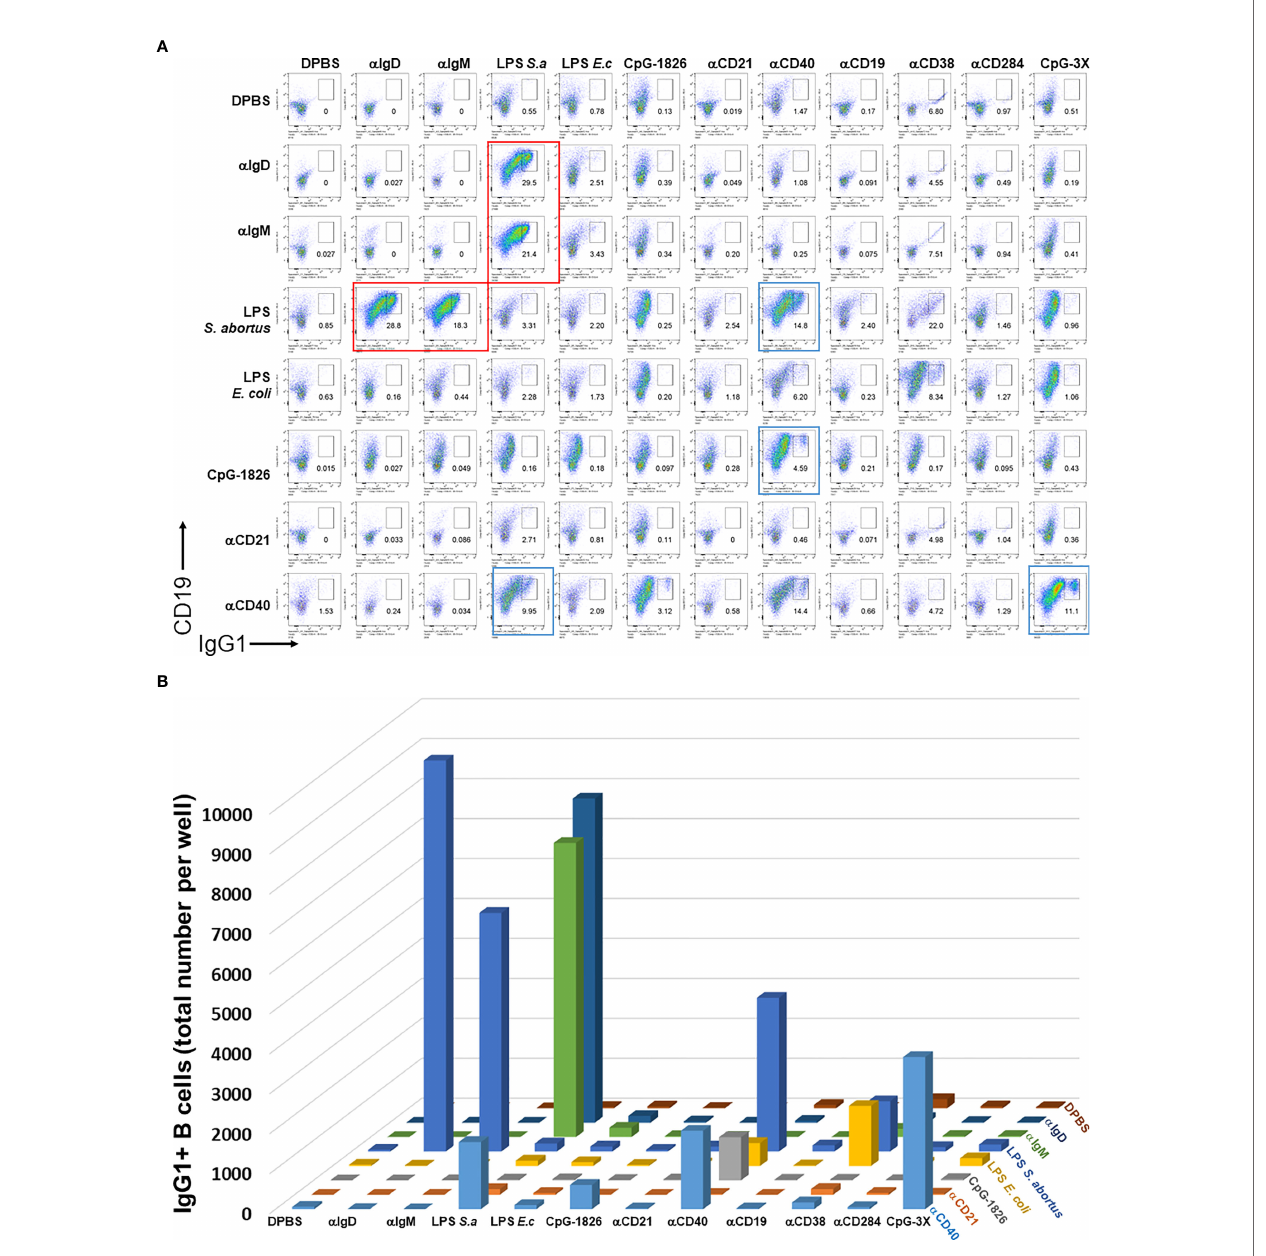
FIGURE 1 | Distinct pairwise combinations of T-I and T-D signals for B cell activation and class switching. (A) Biotinylated T-I stimuli (0.15 m g/ml biotin-anti-IgD clone 11-26c, 0.15 m g/ml biotin-anti-IgM clone RMM1, 0.5 m g/ml biotin-LPS from either E. coli or S. abortus equi , 1.5 m g/ml biotin-CpG-1826, 5 m g/ml biotin-CpG- 1826-3X, 0.5 m g/ml biotin-anti-CD19, 0.5 m g/ml biotin-anti-CD21, 0.5 m g/ml biotin-anti-CD284) and T-D stimuli (0.5 m g/ml biotin-anti-CD40, 0.5 m g/ml biotin-anti- CD38) were fi rst mixed with 1 m g/ml streptavidin in each well of a V-bottom 96 well plate at rt for 2 hrs. DPBS was used to bring volume for each well of these biotinylated stimuli conjugated to streptavidin to a fi nal 20 m l. They were then used to stimulate single cell suspensions (2.5 x 10 5 cells/ml in each well) from mouse spleens in FBS-RPMI medium supplemented with 50 m M beta-mercaptoethanol (BME) and 25 ng/ml IL-4 in fl at bottom 96 well plates for 4 days. Notice that the concentrations of stimuli can be converted to absolute amounts added per 250 m l V-well during the fi rst biotin conjugation step by dividing by 4, e.g. 1 m g/ml streptavidin per cell culture means that 0.25 m g streptavidin was added to each well. Cells were then surface stained with antibodies to CD19, IgG1, and other B cell markers (not shown in these plots), and the viability dye 7AAD. Single viable B cells were plotted and the percent of IgG1 + cells is shown in each dark gate. Larger red rectangles show selected pairwise combinations that induce the most cell proliferation and CSR, which notably include biotinylated LPS + either anti-IgM, anti- IgD or CD40, and CpG + anti-CD40. (B) 3D chart showing the total number of IgG1 + B cells induced by pairwise combinations of stimuli from (A) above. Note that the fi rst eight components in columns and rows are identical and therefore the assays for this 8 x 8 matrix is done in duplicate. This is particular prominent for the synergistic combination of LPS ( S. abortus equi ) and either anti-IgD or anti-IgM in the upper left corner; these correspond to the four plots delineated with red rectangles in (A) . Color coding is the same for all rows and varies for all